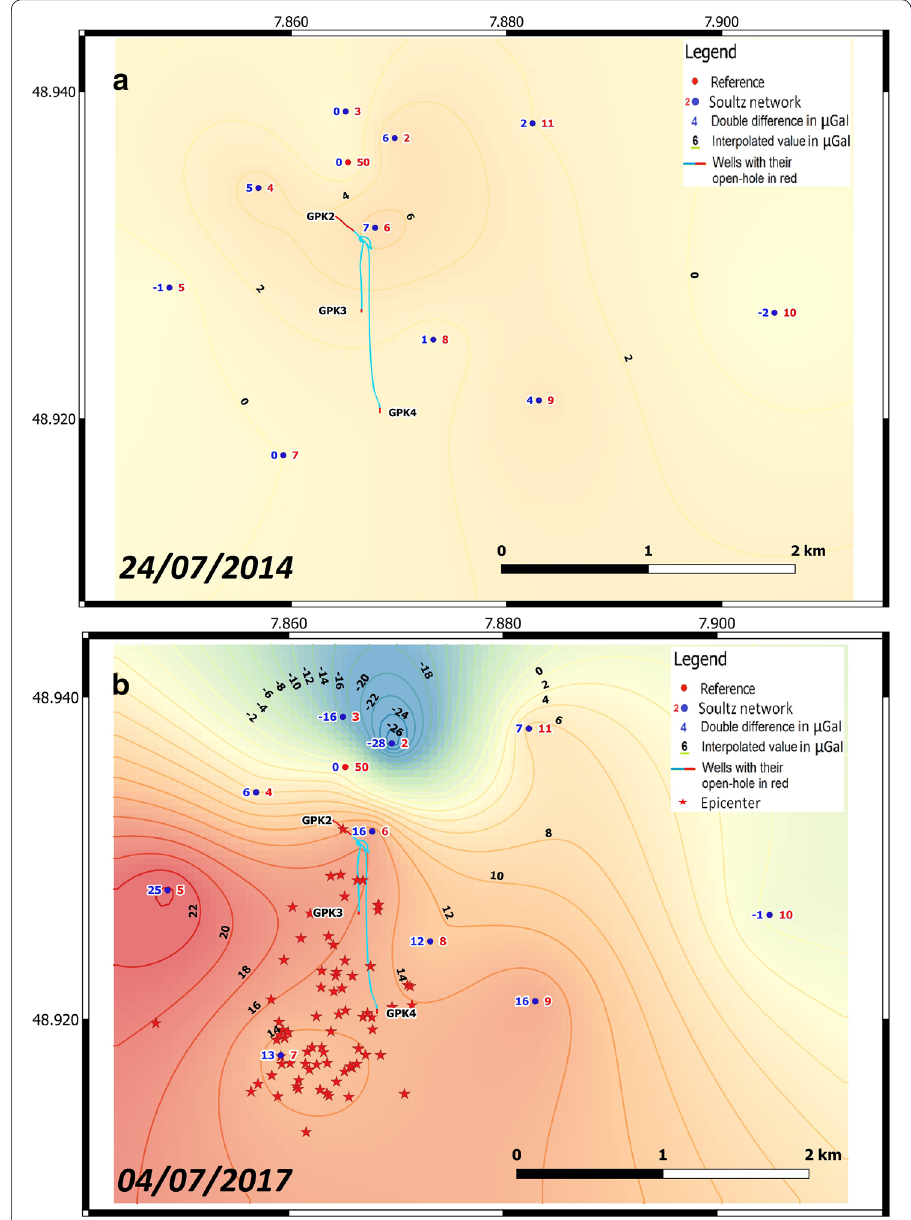
Fig. 12 Soultz‑sous‑Forêts maps of interpolated gravity double difference in µGal measured the 24th of July 2014 ( a ) and the 4th of July 2017 ( b ) before and after the beginning of the production, respectively. The geothermal energy exploitation began on the 24th of June 2016. The same interpolation color scale is used for the two maps. The station codes are indicated in red and the double differences in blue. The isolines val‑ ues are written in black. The wells are represented in blue with their open‑hole in red: GPK3 and GPK4 wells are the injection wells and GPK2 well is used for the production. We superimposed also the 2017 cumulated induced seismicity epicenters on the second